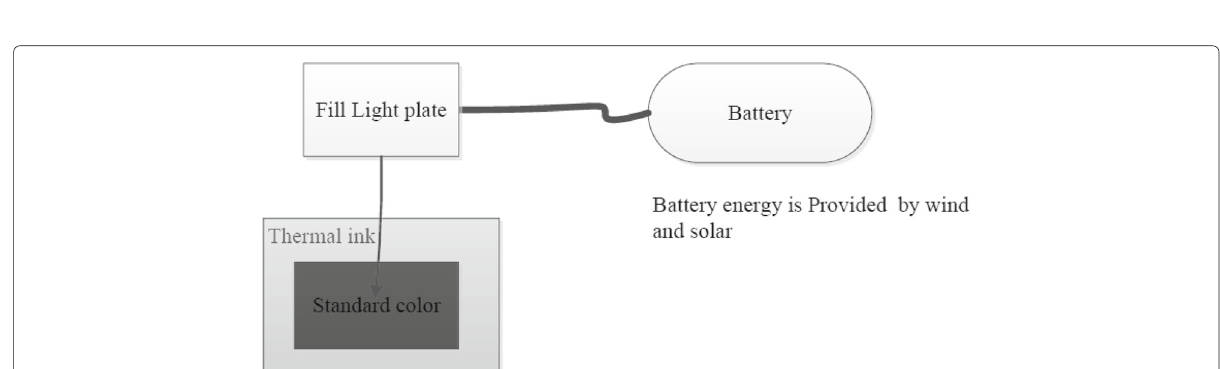
Fig. 4 Schematic diagram of compensation